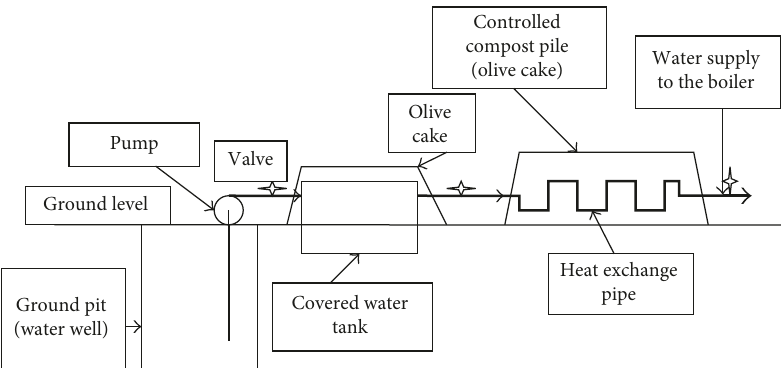
Figure 1: A schematic diagram of the combined system used in this work for hot water production at the olive mill.